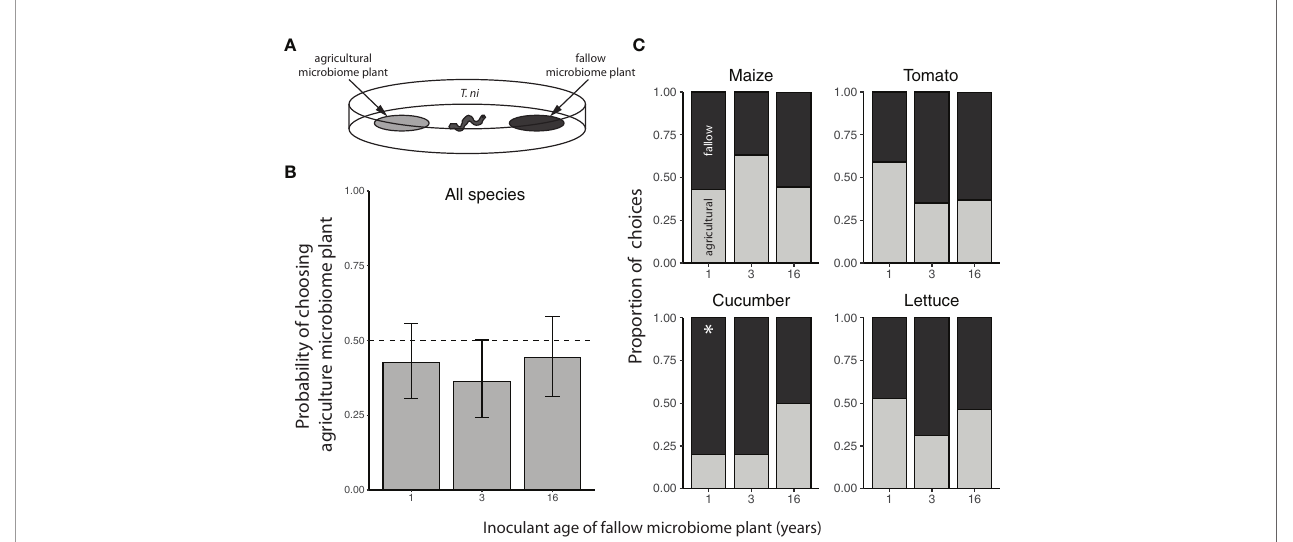
FIGURE 3 | Feeding preference of Trichoplusia ni for maize ( Z. mays ), tomato ( S. lycopersicum ), cucumber ( C. sativus ), and lettuce ( L. sativa ) inoculated with agricultural or fallow microbiomes of different ages. (A) Neonatal T. ni larvae were simultaneously presented with a disc of leaf tissue from a plant inoculated with an agricultural soil microbiome and a disc of leaf tissue from a plant inoculated with a microbiome from a fallow fi eld (1, 3, or 16 years post-agriculture) in an arena. All choice tests were performed within plant species. Choices represent the microbiome treatment of the disc each larva was fi rst observed to eat. (B) Probabilities (with 95% con fi dence intervals) of selecting the agriculture microbiome-inoculated plant averaged across plant species; the dashed line indicates an equal preference for agriculture- and fallow-microbiome treated plants. (C) Choices by crop species; light grey bars indicate the proportion of larvae that chose the plant treated with the agricultural soil microbiome whereas the dark grey bars indicate instances in which the fallow microbiome plant was chosen. N = 9-22 tests per plant species × fallow inoculant age level after omitting larvae that did not feed within the 2 h trial. An asterisk (*) indicates a signi fi cant preference.